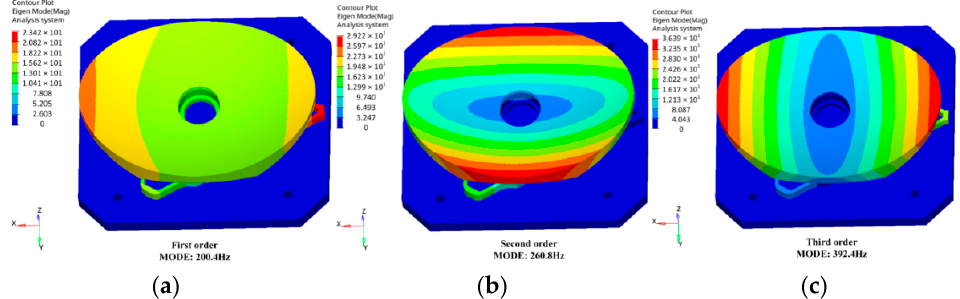
Figure 11. The result of model analysis: ( a ) first order; ( b ) second order; ( c ) third order. Table 3. Model participation factors in the first three modes. Mode Frequency